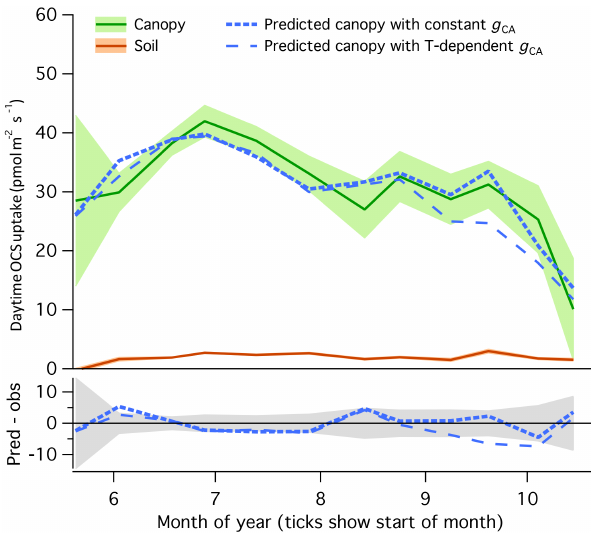
Figure 3. Composite seasonal cycles (including the years 2012 and 2013) of daytime soil uptake, canopy uptake, and predicted canopy uptake from Eq. (1), along with the differences between predicted and observed canopy uptake. Lines connect the mean values of each 2-week bin. Pale bands depict standard errors in the means as esti- mated from the variability within each bin.